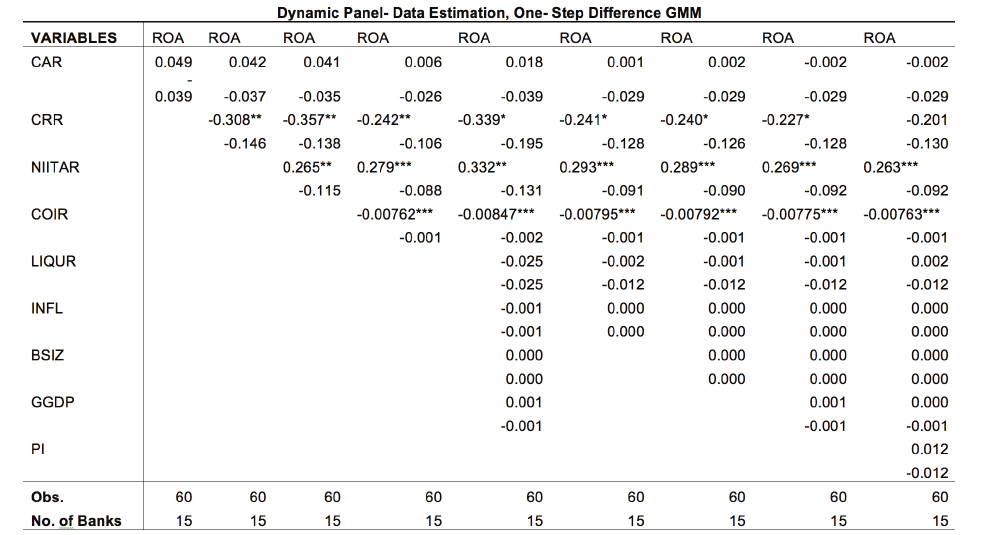
The Dynamic Panel- Data